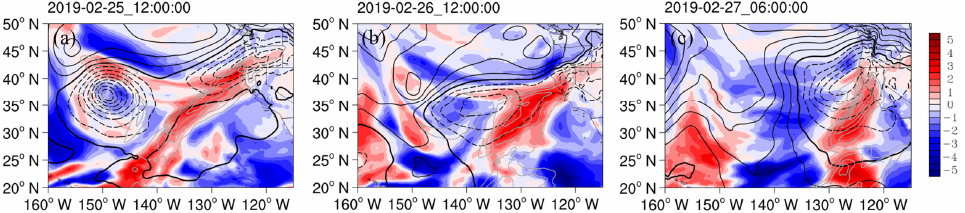
Figure 5. Maps of the synoptic geopotential anomaly ( φ ∼ 1 ; contours; in m 2 s − 2 ) and specific humidity ( q ∼ 1 ; shadings; in g/kg) at 850 hPa: ( a ) 25 February at 12:00 UTC, ( b ) 26 February at 12:00 UTC, ( c ) 27 February at 06:00 UTC. Gray contours denote ARs (IVT >= 250 kg m − 1 s − 1 ) with an interval of 100. The interval of black contours is 150 (solid lines for positive values, dashed lines for negative values, and bold line for zero value).